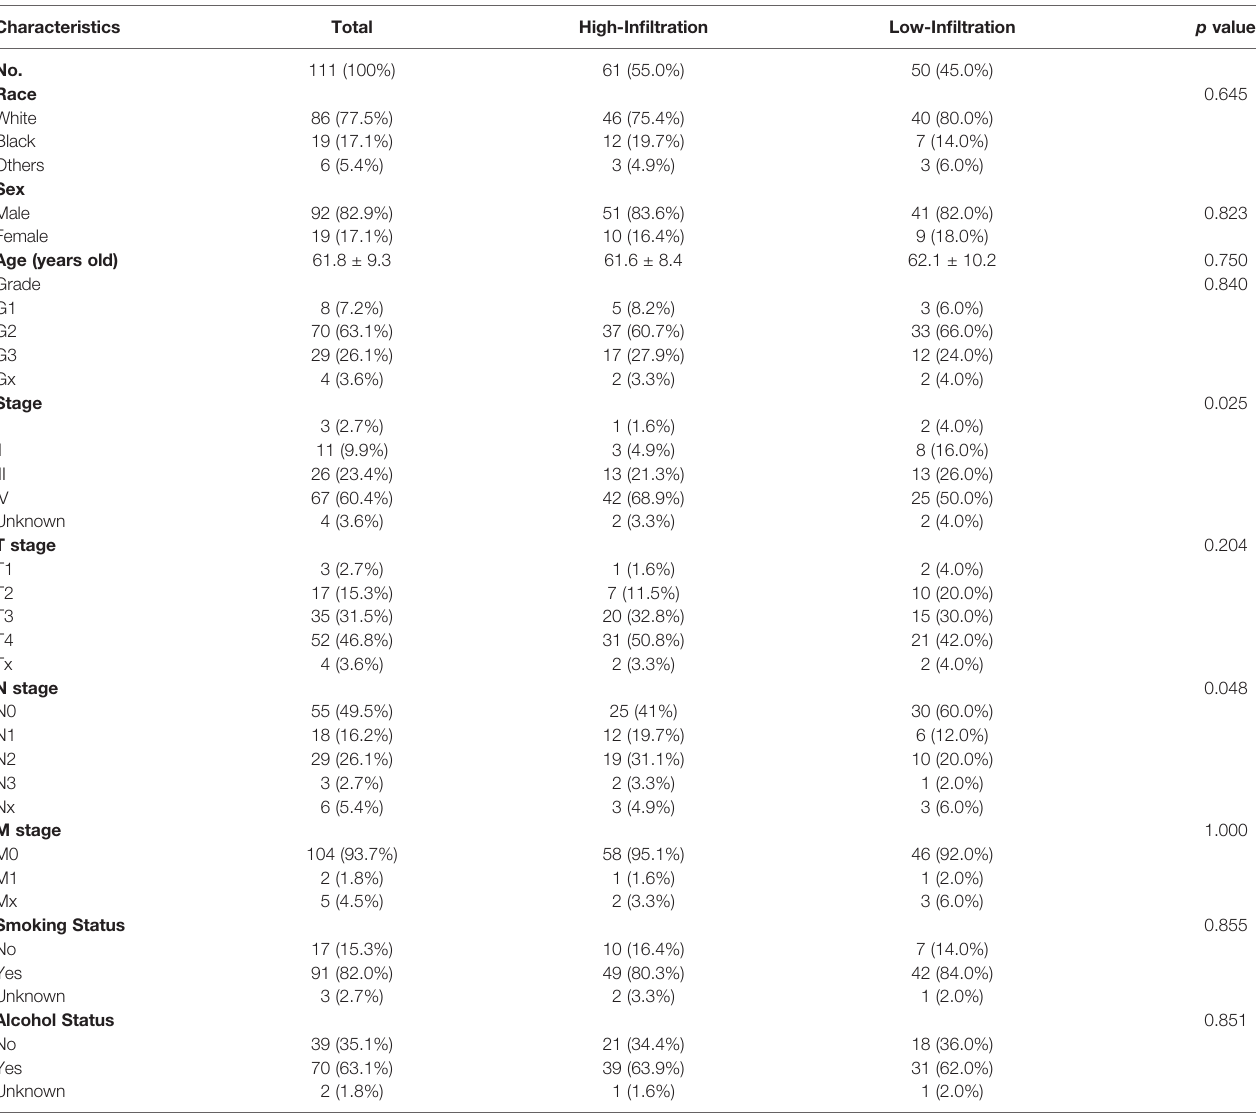
TABLE 1 | Clinical characteristics of patients with different immune in fi ltration